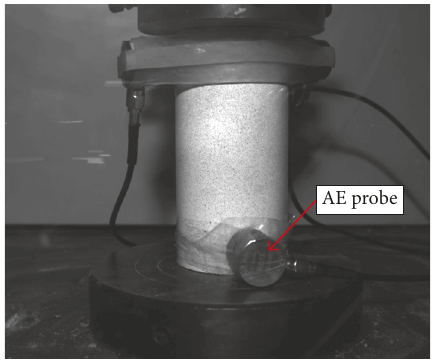
Figure 2: Use of acoustic emission for the detection of